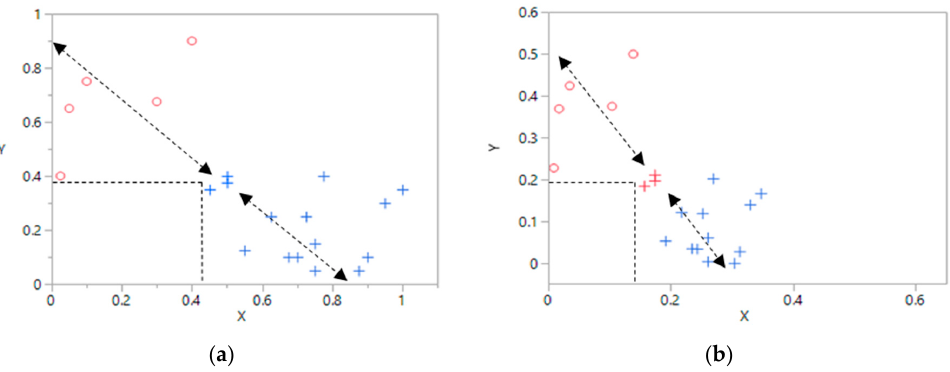
Figure A1. ( a ) Clustering in the original coordinate system; ( b ) Clustering using scaled